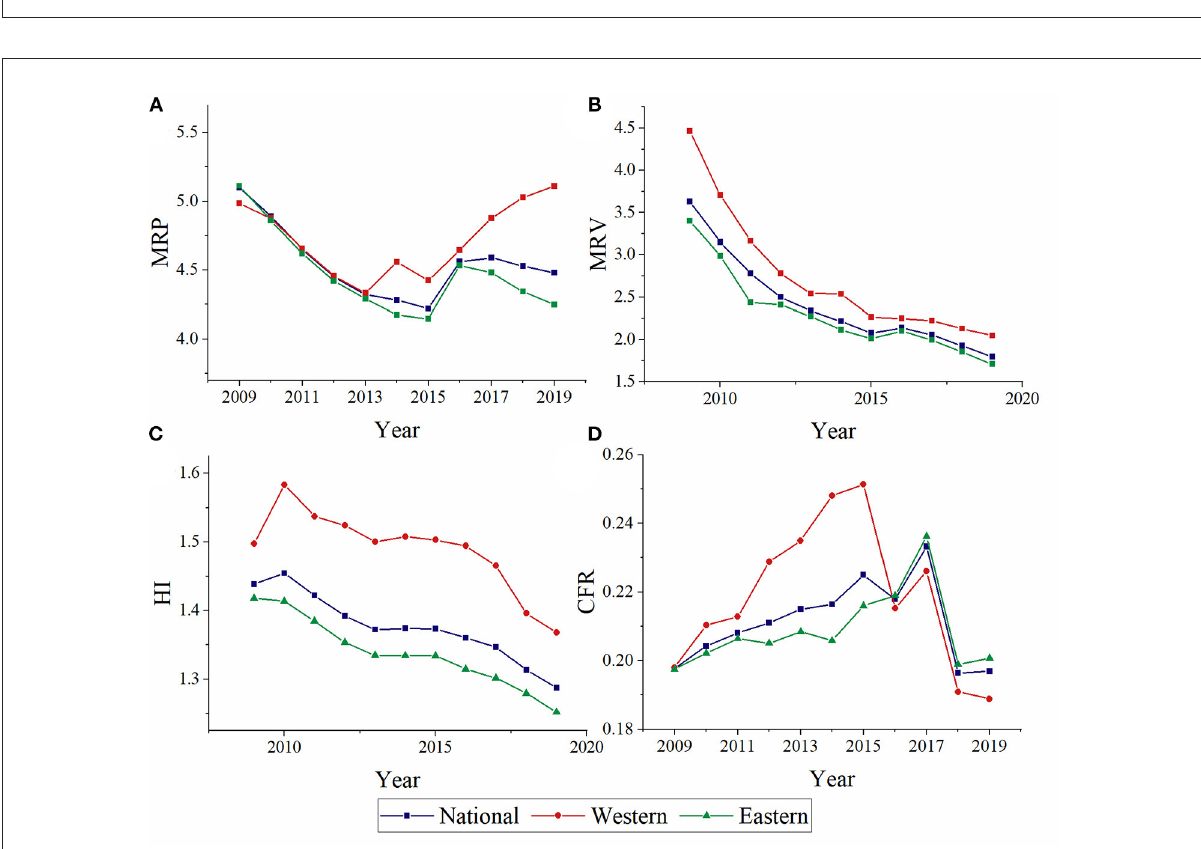
FIGURE3 Annual distribution of MRP (A) , MRV (B) , HI (C) , and CFR (D) at western, eastern, and